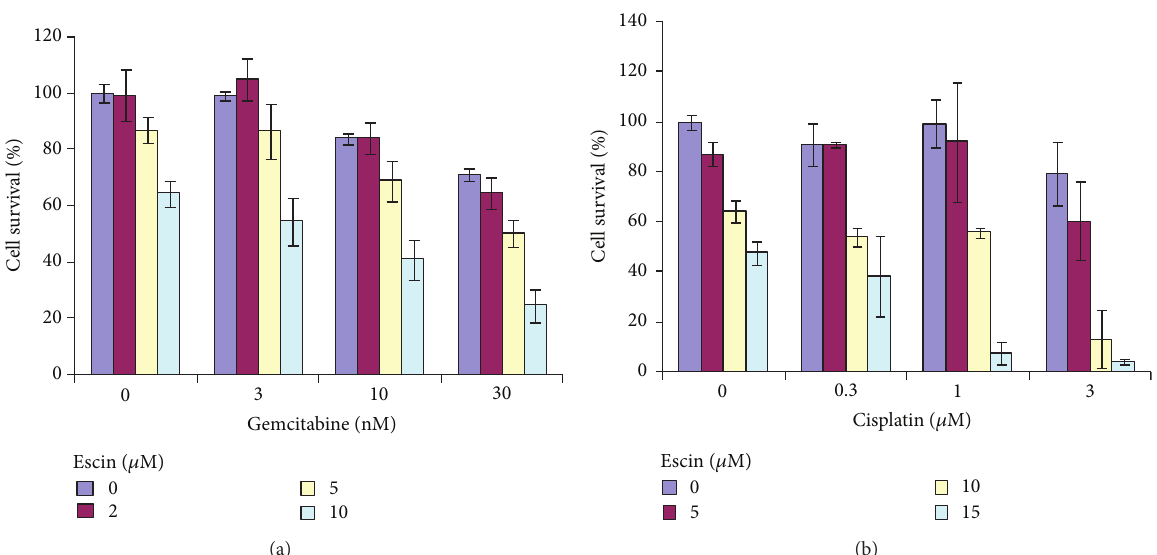
Figure 6: Effect of Escin combined with gemcitabine or cisplatin on survival of Panc-1 cells. Panc-1 cells were plated in 96-well plates and treated with gemcitabine (3, 10, and 30nM) for 3 days. Cell survival was assessed using the XTT-based cell proliferation assay. Three independent experiments were conducted in